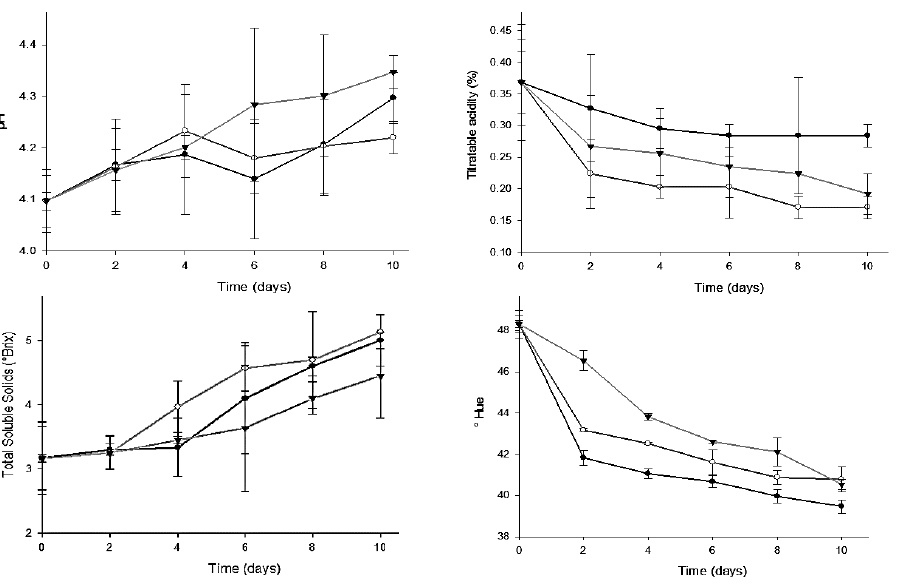
Figure 3. pH values, titratable acidity, total soluble solids content, and color surface (Hue angle) of tomato fruits covered with edible coating (Triangle) or edible coating and F. cernua extract (White dot) or distilled water as a control (Black dot).